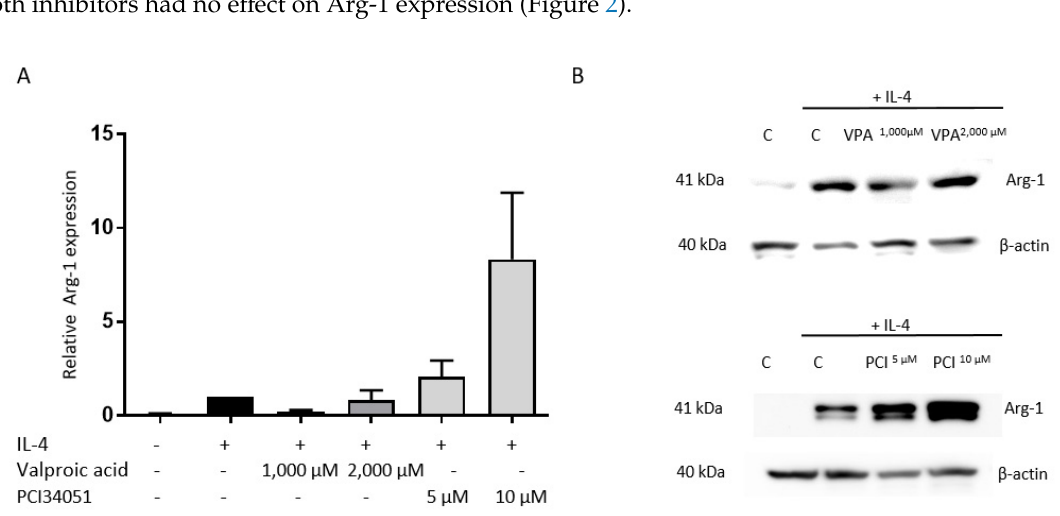
Figure 2. PCI-34051 and VPA have no e ff ect on Arg-1 expression. BMDMs were stimulated with IL-4. After 1 h, these cells were treated with VPA at 1000 µ M or 2000 µ M as a control or with PCI-34051 at 5 µ